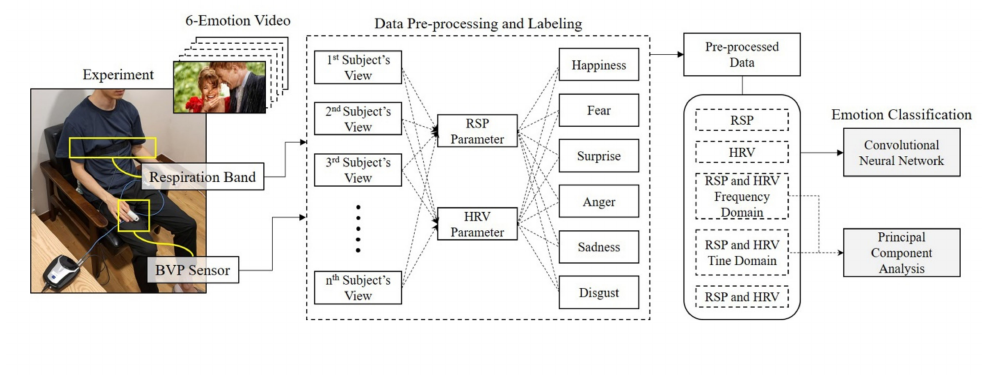
Figure 1. Overall flow of the